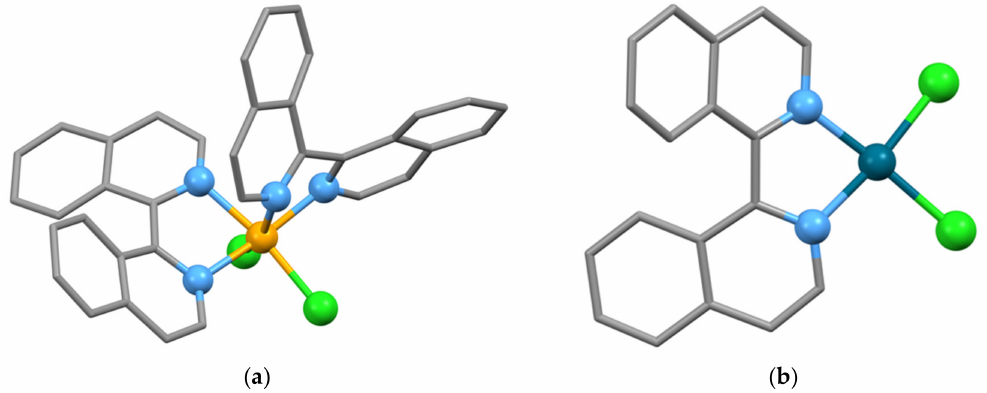
Figure 15. ( a ) A molecule of the complex cis -( ∆ )-[Ni{{ M )-biiq}{( P )-biiq}Cl 2 ] present in cis - rac -( ∆ )- [Ni{{1 M )-biiq}{(1 P )-biiq}Cl 2 ]; equal numbers of cis -( Λ )-[Ni{{1 M )-biiq}{(1 P )-biiq}Cl 2 ] molecules are present in the lattice. The donor atoms and nickel are shown as balls, and hydrogen atoms are omitted for clarity; ( b ) one of the two independent molecules of [Pd(biiq)Cl 2 ] present in cis - rac -[Pd{(1 M )- biiq}Cl 2 ]. The molecule represented is cis -[Pd{(1 P )-biiq}Cl 2 ]. The other independent molecule possesses the M configuration. The donor atoms and palladium are shown as balls and hydrogen atoms omitted for clarity.